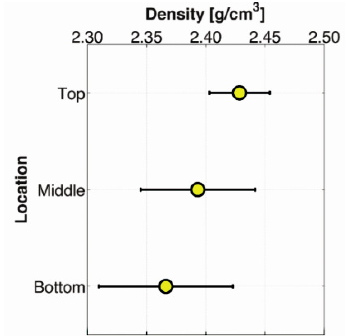
Fig. 4. Density for each location; circle markers indicate the mean; error bars extend one standard